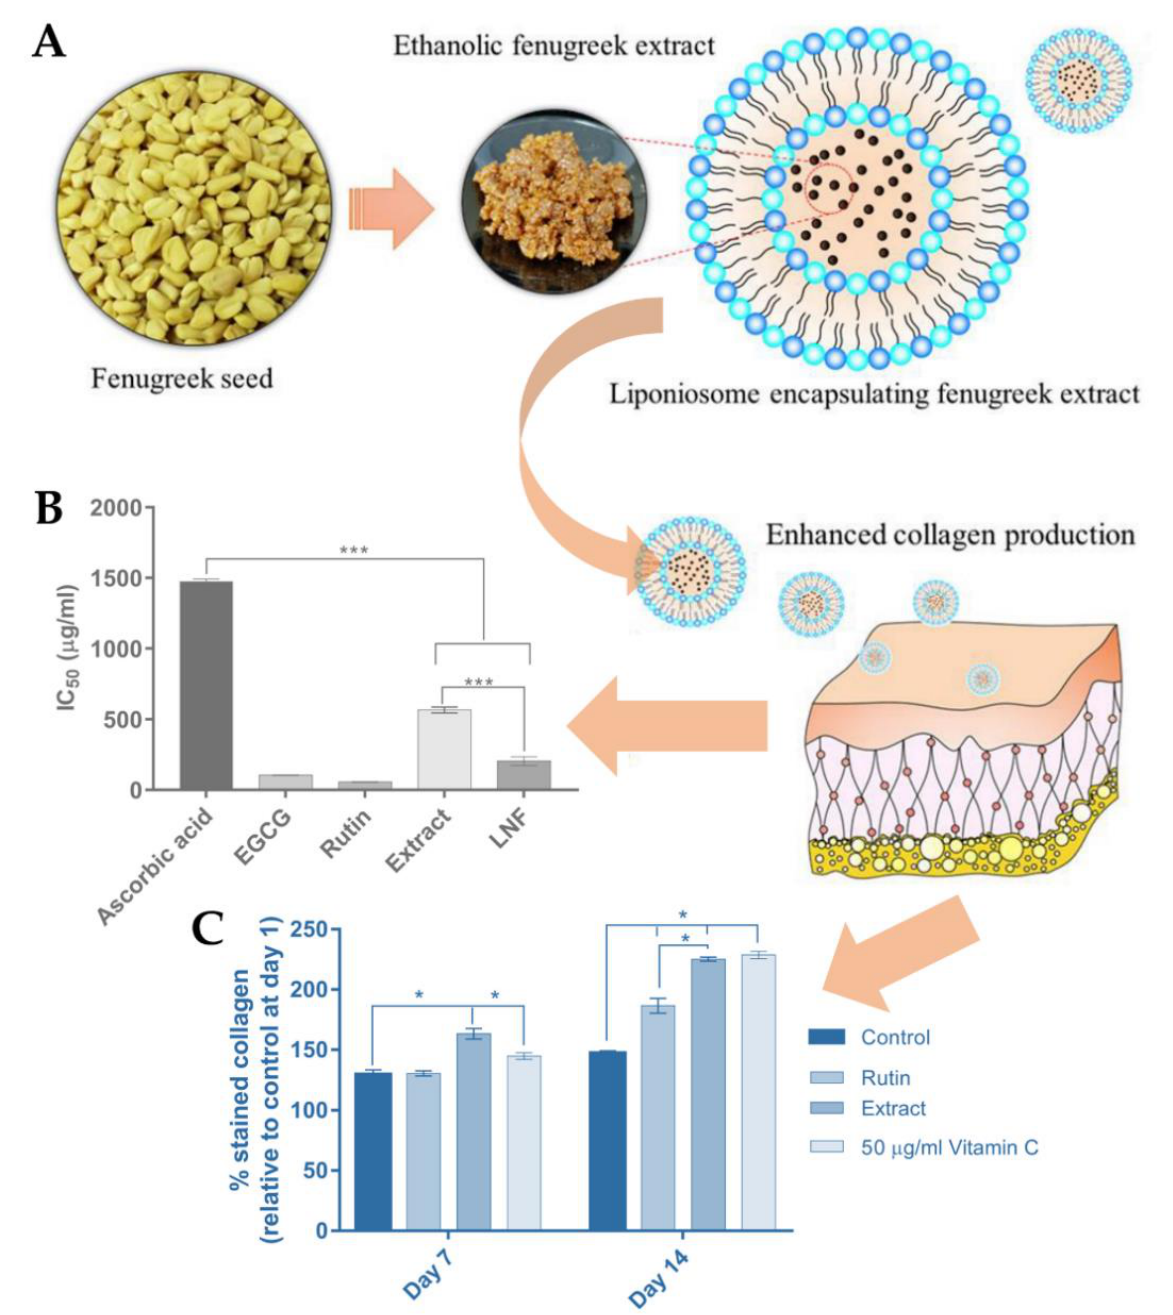
Figure 4. ( A ) Schematic representation of fenugreek extract encapsulation within the developed liponiosomes, and intended effect on the skin; ( B ) in vitro collagenase inhibition assay results of the fenugreek extract without being encapsulated (“Extract”) and encapsulated within the devel- oped liponiosomes (“LNF”); ( C ) collagen production after treatment with the fenugreek extract (and controls); * p < 0.05, *** p < 0.001; adapted from Eaknai et al.